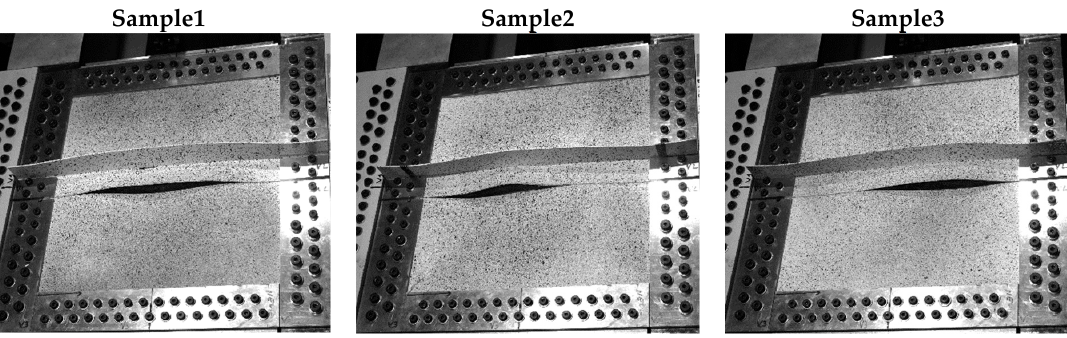
Figure 24. Observation of the three samples at the final stage of the compression tests: the stiffener is entirely debonded and the debonding crack is open along most of its length.